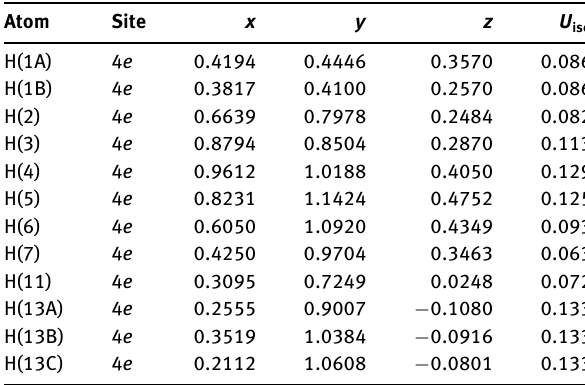
Table 2: Fractional atomic coordinates and isotropic or equivalent isotropic displacement parameters (Å 2